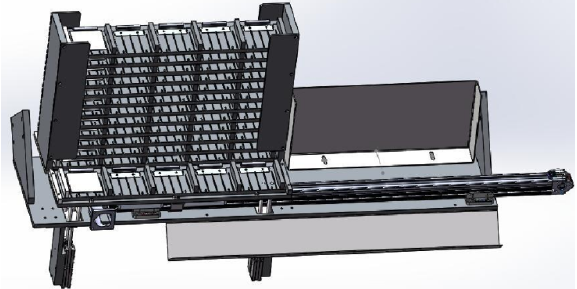
Fig. 5. Feeding mechanism of abrasion resistance testing